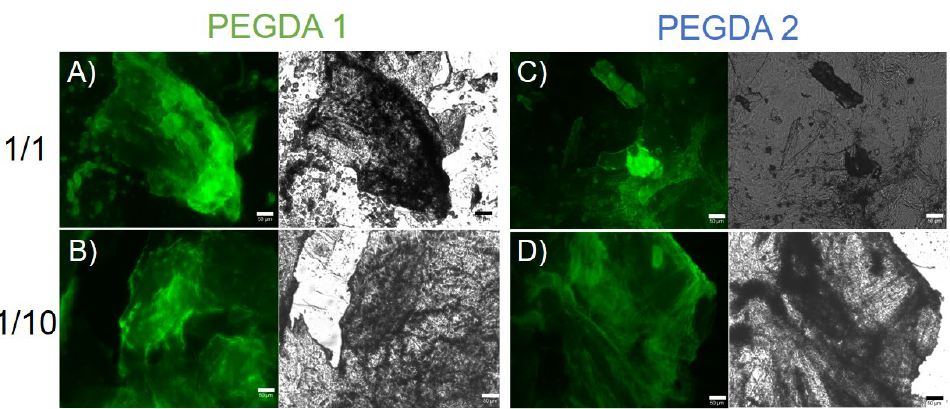
Figure 4. For each panel, fluorescence images (left) and optical images (right) of mixed xerogels ( A ) Fmoc-FF/PEGDA1 1/1, ( B ) Fmoc-FF/PEGDA1 1/10, ( C ) Fmoc-FF/PEGDA2 1/1 and ( D ) Fmoc- FF/PEGDA2 1/10 stained with 50 µmol/L ThT solution. Samples are imaged in the spectral regions of the GFP (Green Fluorescent Protein, λ exc = 488 nm, λ em = 507 nm) and in the bright field. Scale bar = 50 µm.